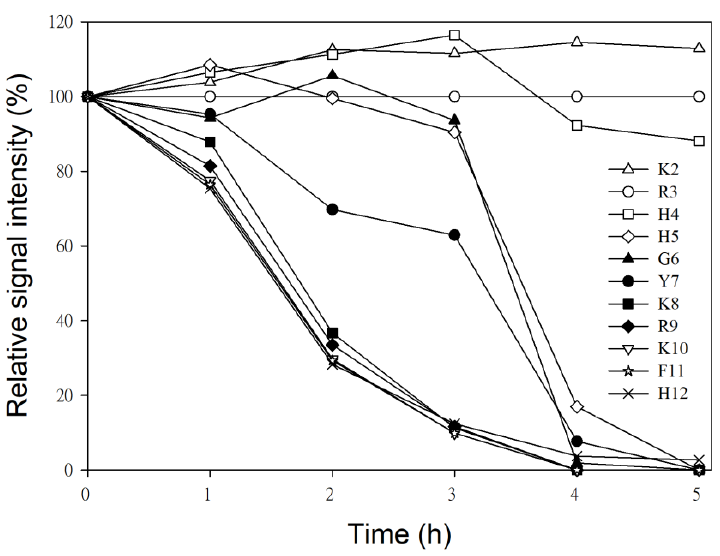
Figure 6. Time-dependent decrease in the intensity of 15 N- 1 H NMR signals of P-113 residues during incubation with C. albicans .